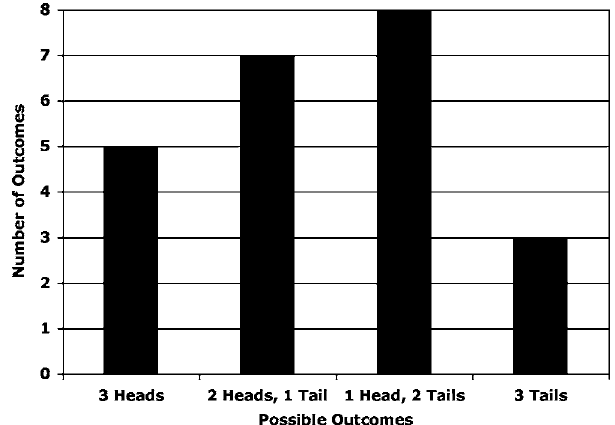
FIG. 1. Representative probability histogram chart for the three coin toss.